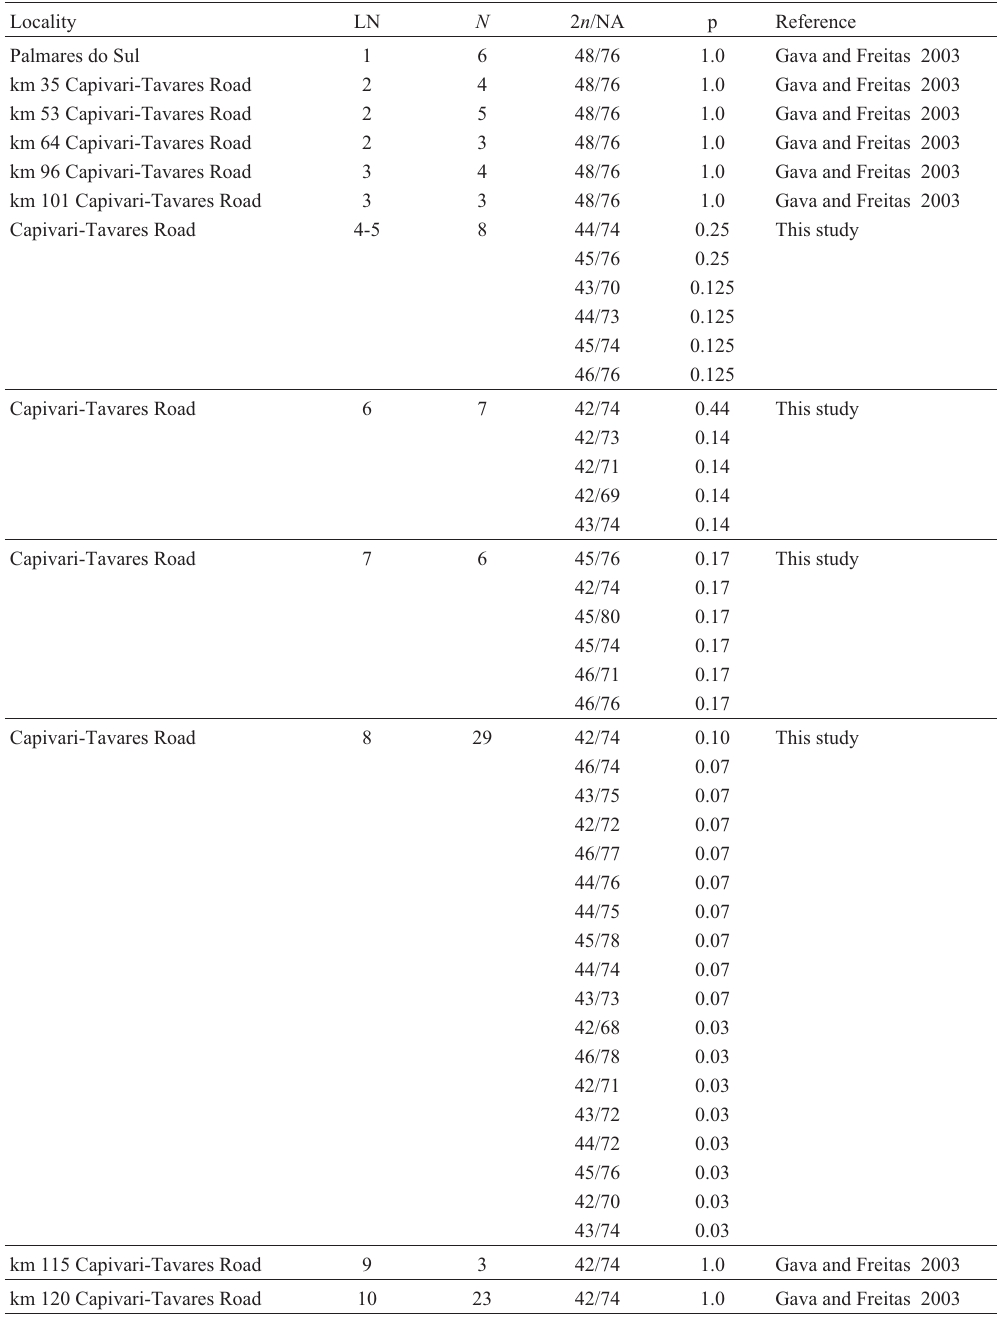
Table 1 - Sample localities of 101 specimens of Ctenomys minutus . (LN=locality number, N =sample size, 2 n /NA=diploid number and autosomal arm numbers, P = frequency of karyotypes) and Reference= sample collection reference. Locality LN N 2 n